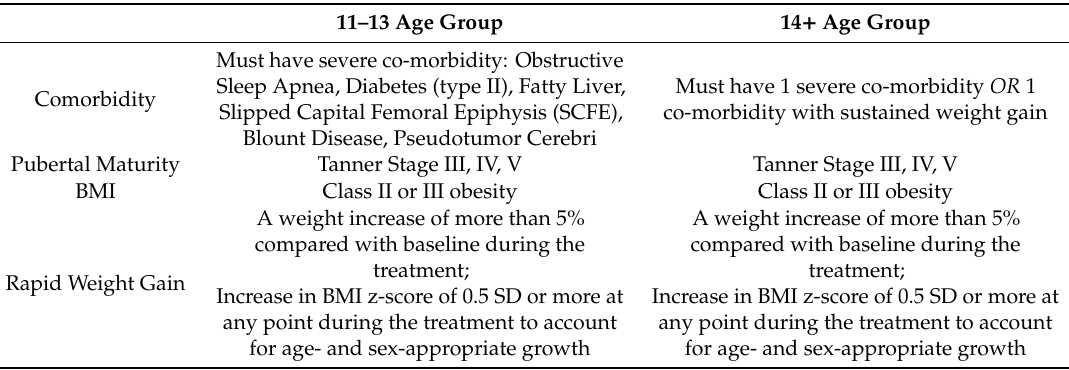
Table 1. Adolescent inclusion criteria for the rPSMF